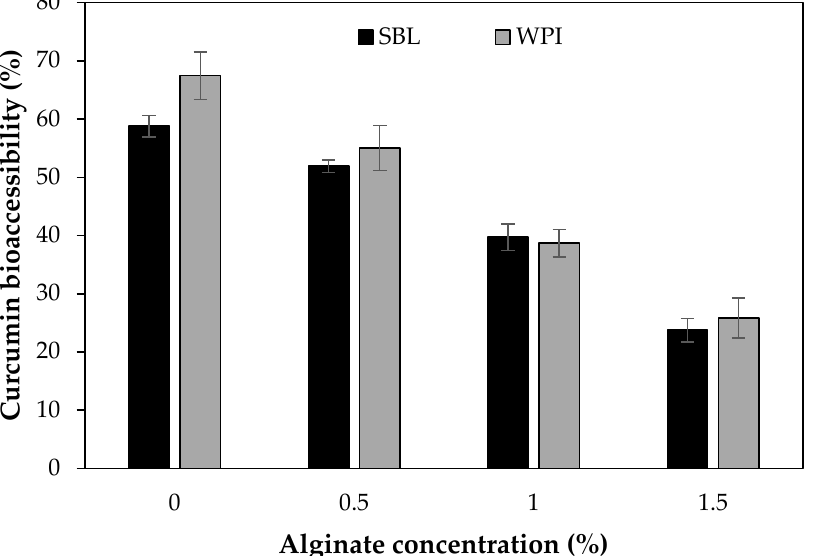
Figure 9. Curcumin bioaccessibility of nanoemulsions stabilized with soybean lecithin (SBL) or whey protein isolate (WPI) and different sodium alginate concentrations (0, 0.5, 1 and 1.5%).